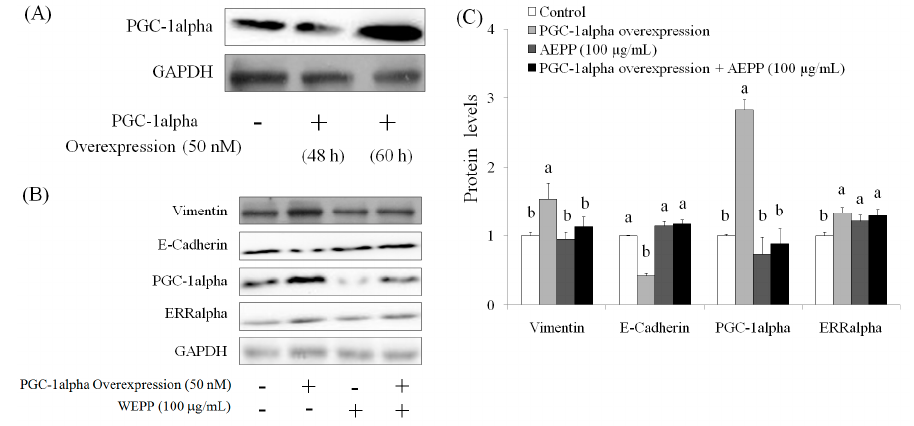
using different letters ( p < 0.05).